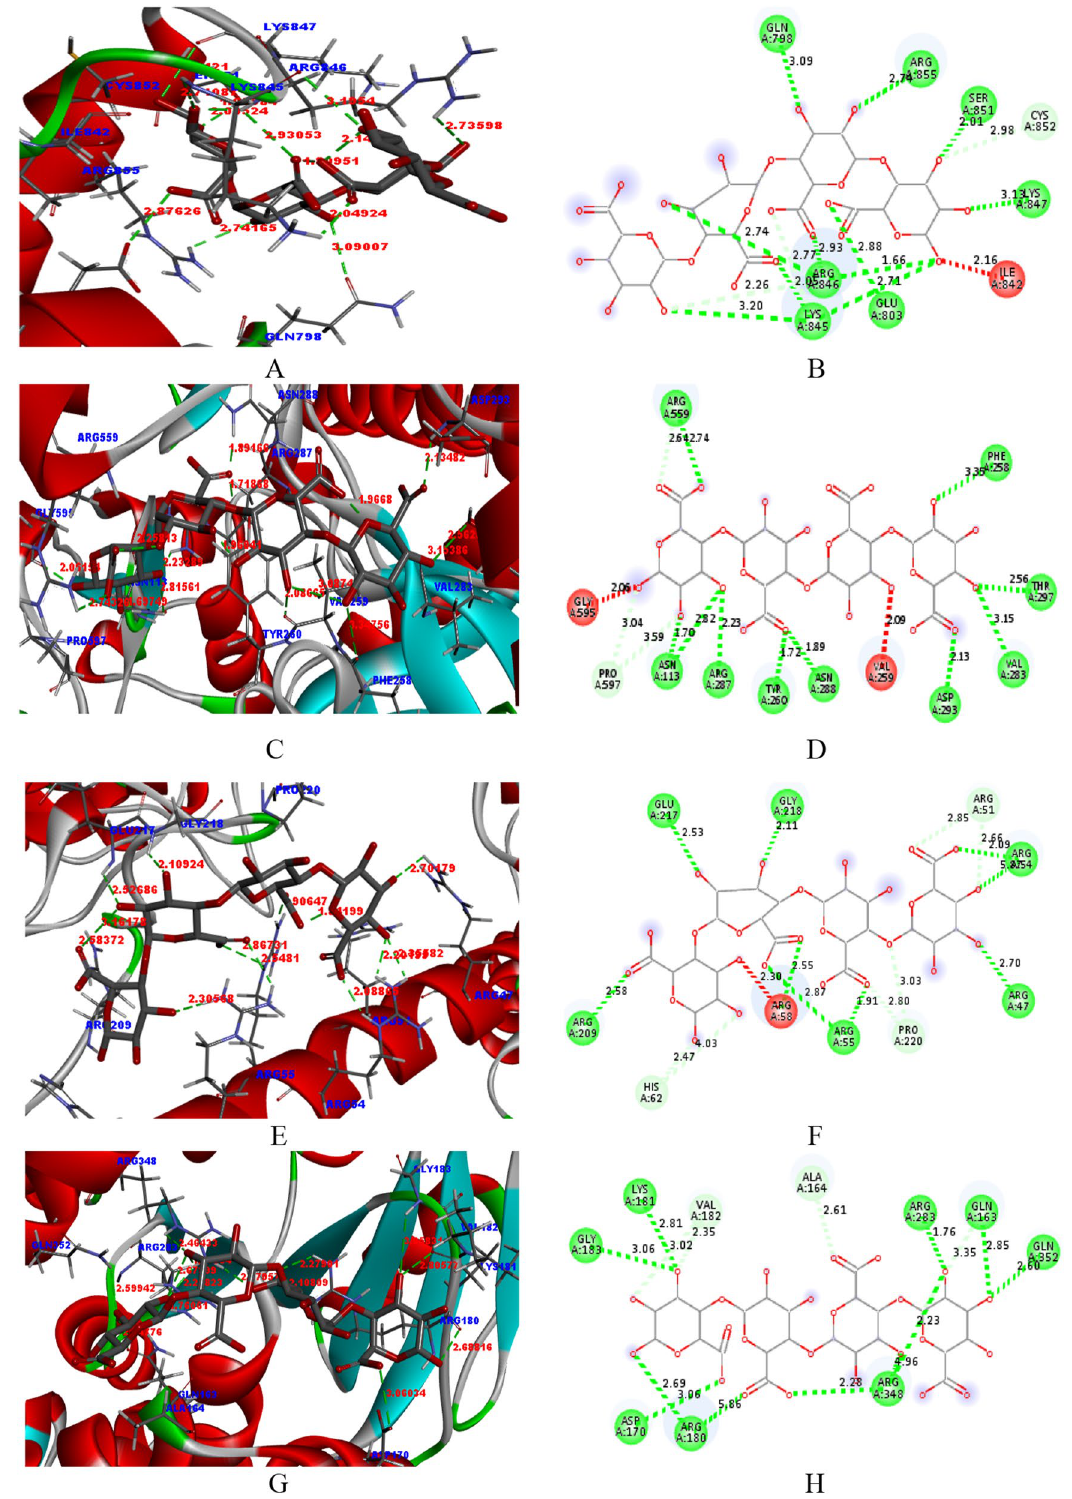
Figure 8. 2D- and 3D- views for the interaction of pectin with the receptors (1e3g, 3t0c, 5czz, 6j7l, 6v40, 5ibs, 5zsy and